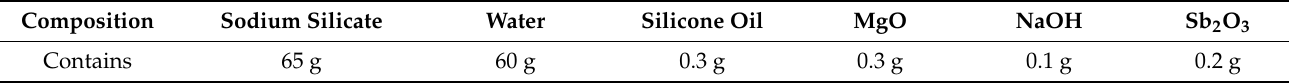
Table 1. Other additives of electrothermal GNs